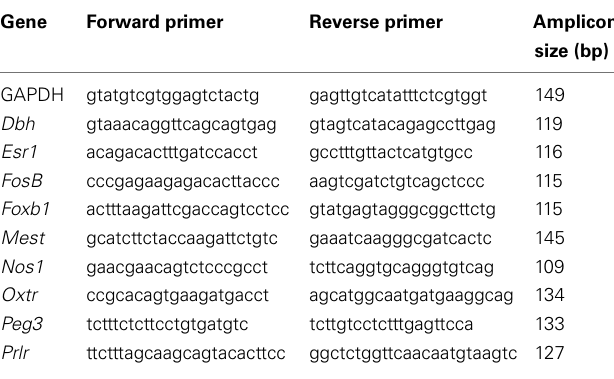
Table 1 | Sequences of primers used for